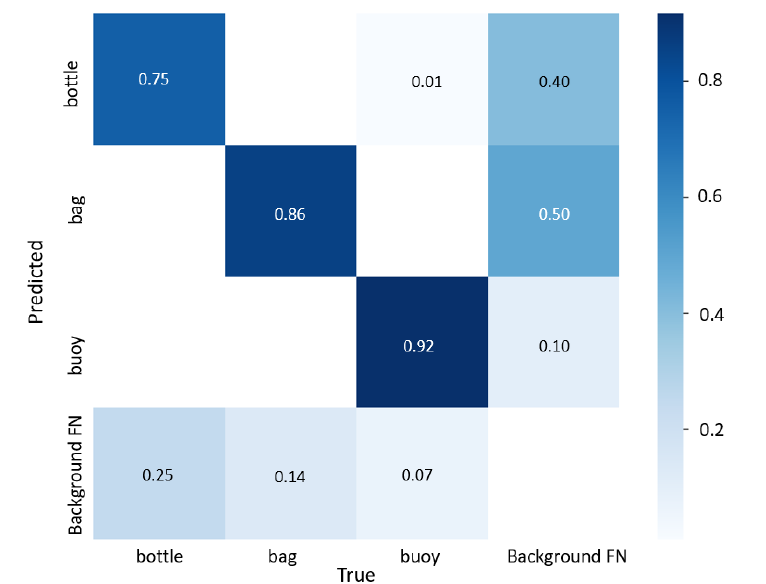
Figure 8. Normalised confusion matrix showing the output from the final model run over the validation data set. Bottles were predicted correctly by the model 75% of the time, and bottles were incorrectly identified as background 25% of the time. Bags were correctly identified by the model 86% of the time and wrongly identified as background 14% of the time. Buoys were correctly identified 92% of the time and misidentified as background 7% of the